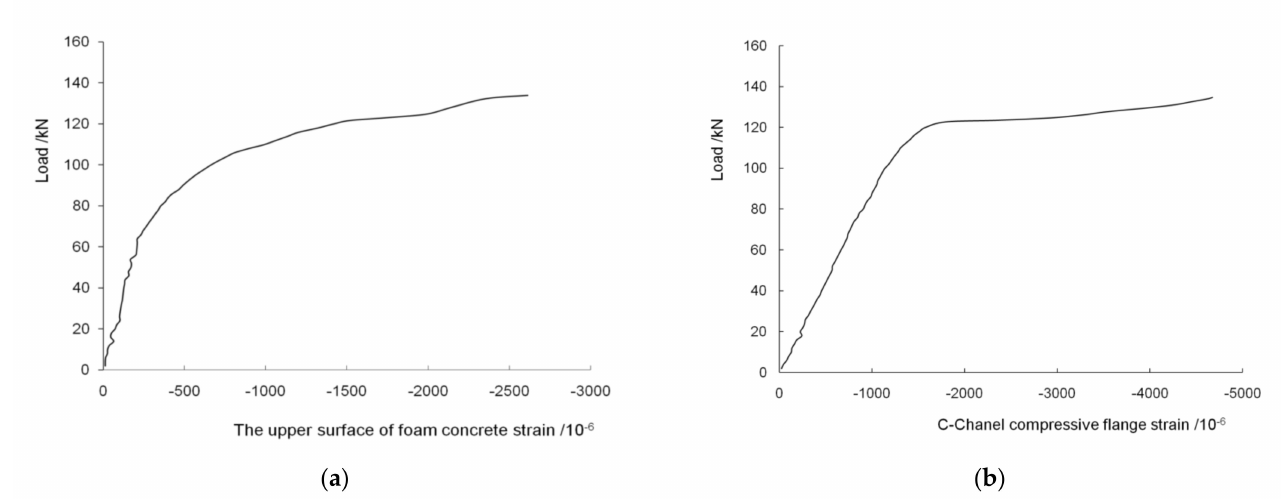
Figure 9. Load-strain relationships of the top surface of the foam concrete and bottom surface of the cold-formed thin-walled C steel channels. ( a ) Top surface of the foam concrete slab; ( b ) Top surface of the cold-formed thin-walled C steel channels.